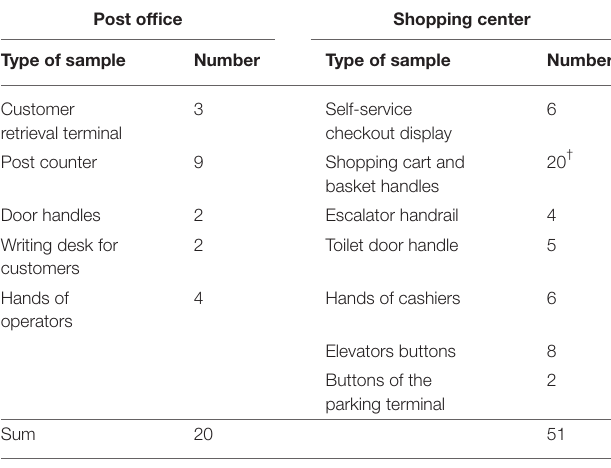
TABLE 1 | Description of the samples collected at the post office and in the shopping